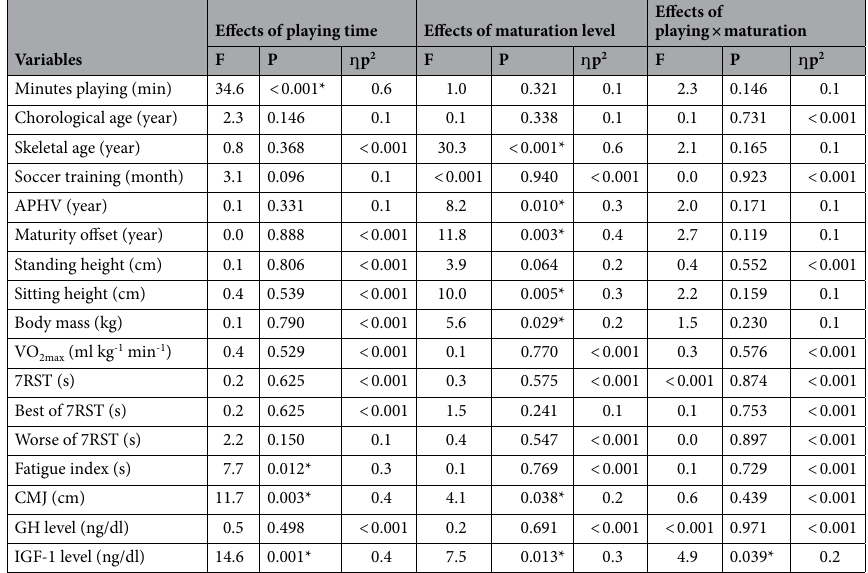
Table 2. Results of MANOVA to test the effect of playing time and maturity groups in inter-variability of under 15 youth football players. APHV age at peak height velocity, VO 2max maximal oxygen uptake, 7RST 7